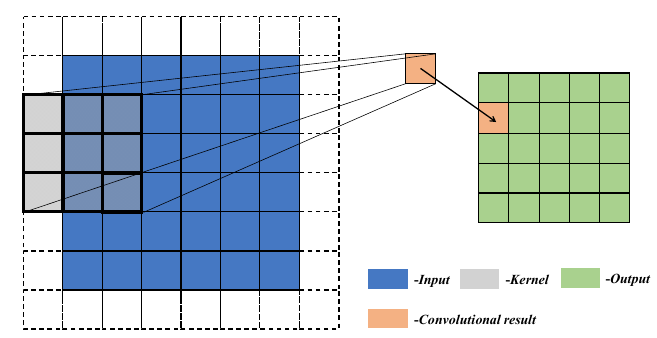
Figure 2. A simple sketch of the deconvolutional layer.